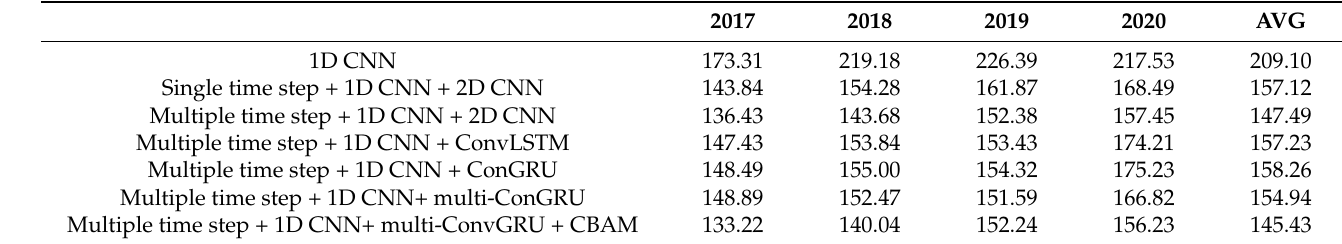
Table 8. Twenty-four hour distance error of eight isobaric surfaces forecast